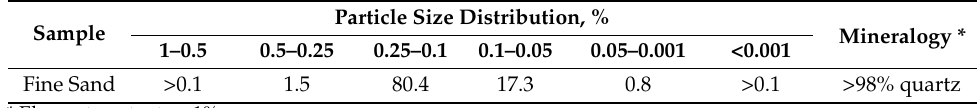
Table 1. Grain sizes and mineralogy of sandy samples. Sample